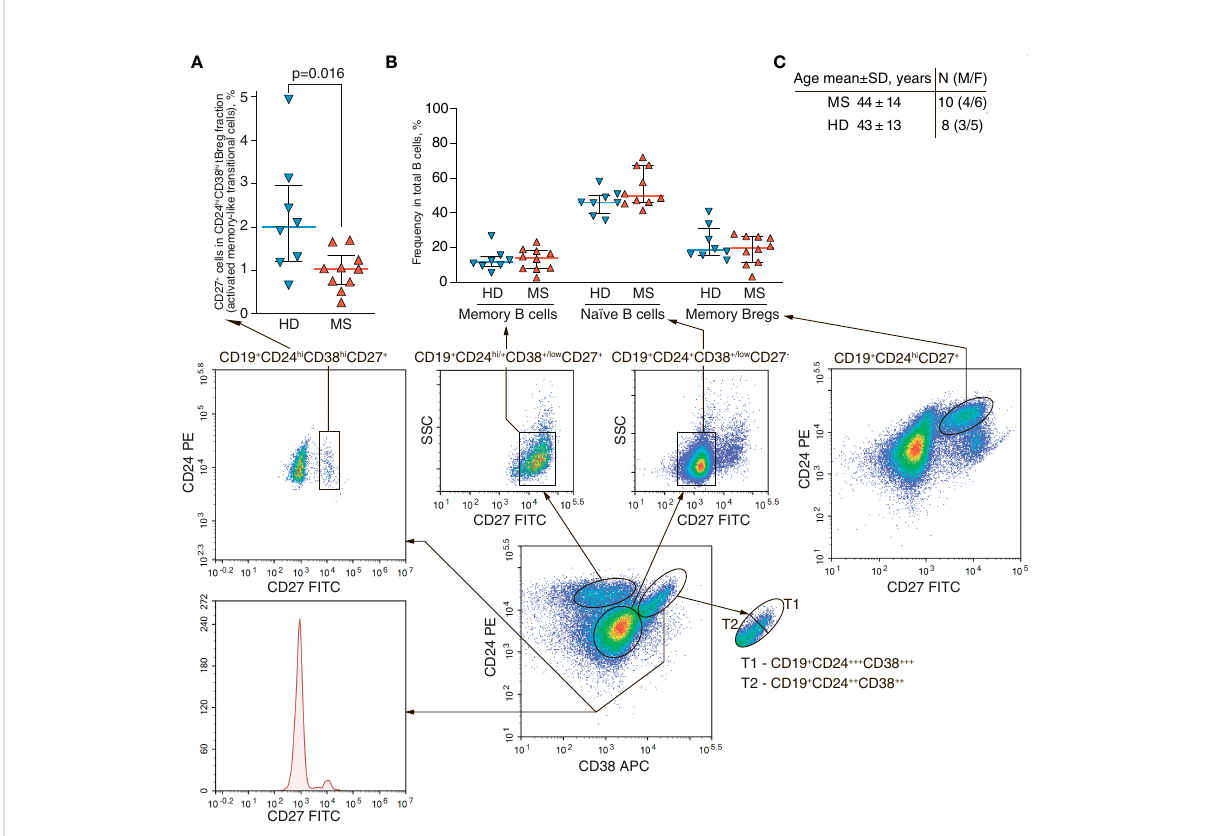
FIGURE 4 Frequencies of the CD27-positive B cells in peripheral blood of MS patients and healthy individuals. (A) The percentage of CD27-positive activated memory-like transitional cells in CD19 + CD24 high CD38 high tBreg subpopulation and (B) the frequency of memory (CD19 + CD24 +/high CD38 +/low CD27 + ), naïve (CD19 + CD24 + CD38 +/low CD27 - ) or memory Breg (CD24 high CD27 + ) among peripheral B cells in multiple sclerosis patients (MS) and healthy donors (HD). The bottom panel shows the gating strategy of fl ow cytometric analysis. (C) Age and gender comparison of MS and HD analyzed in the same experiment. The difference in cell frequency was analyzed by Mann Whitney test. Statistically signi fi cant p -values are